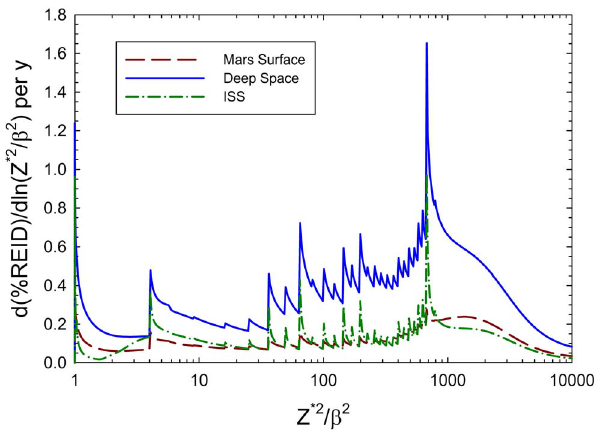
Figure 2. Distribution of %REID for solid cancer for particles represented by Z* 2 / b 2 for deep space, martian surface and ISS orbit for 20 g/cm 2 shield. The full GCR spectrum that traverse astronauts in deep space are more biologically damaging compared to the higher energy GCR that occur in low Earth orbit. doi:10.1371/journal.pone.0074988.g002 Table 2 shows estimates of the maximum number days in space near solar minimum where NASA’s limits are not exceeded for different ages at exposure and demographic variables. Results are for a specific shielding configuration of 20 g/cm 2 aluminum, and